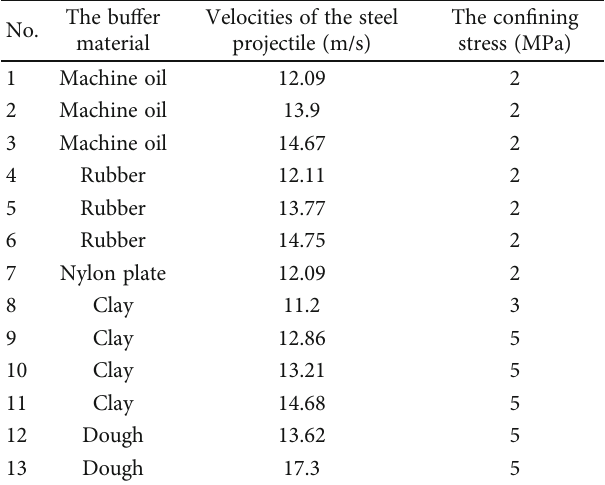
Figure 21: The positive pressure time and stress peak of experiments and large-scale underground explosions. The black color represents the positive pressure time, and the red color represents the stress peak. Table 2: Experimental